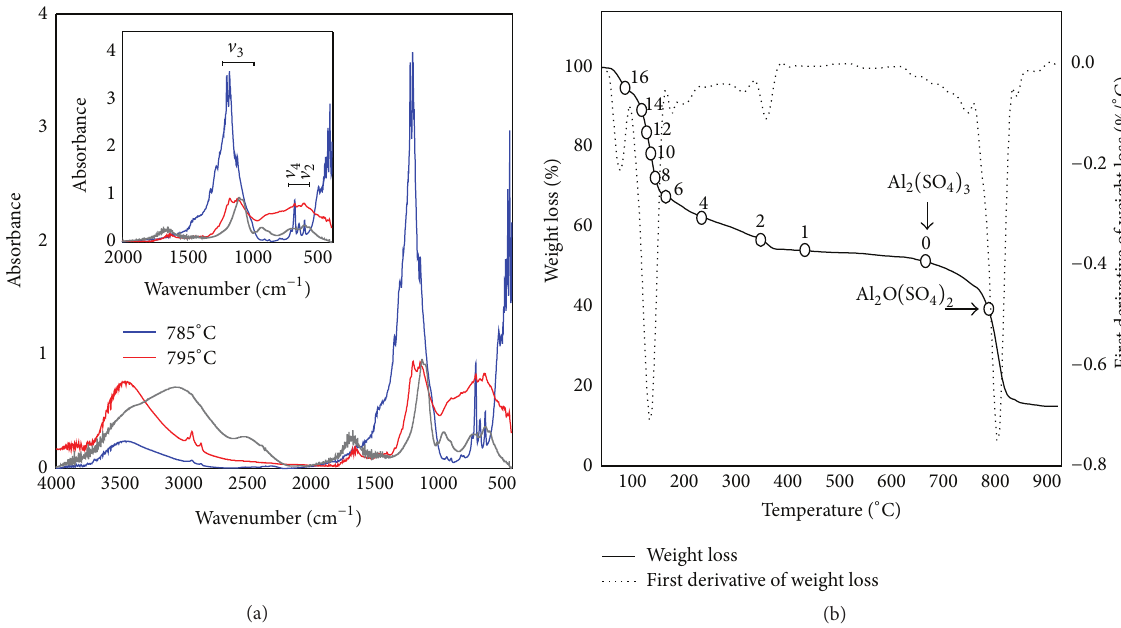
Figure 1: FTIR absorption spectrum of the calcination products (3 h, 785 or 795 ∘ C) of Al 2 (SO 4 ) 3 ⋅ 18H 2 O powder and that of Al 2 (SO 4 ) 3 ⋅ 18H 2 O powder for comparison (grey line) (the main bands are discussed in the text) (a) and thermogravimetric (TG) curve for Al 2 (SO 4 ) 3 ⋅ 18H 2 O